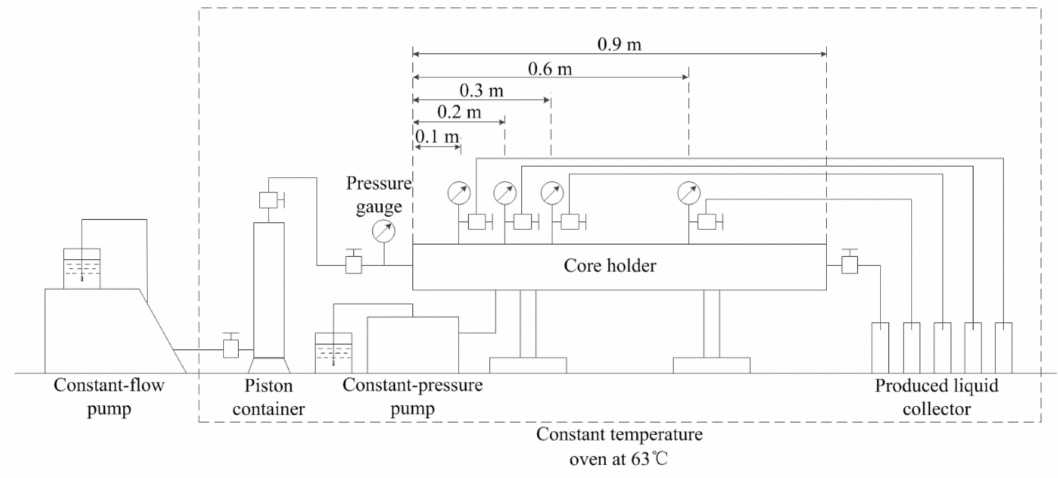
Figure 2. Experiment-process